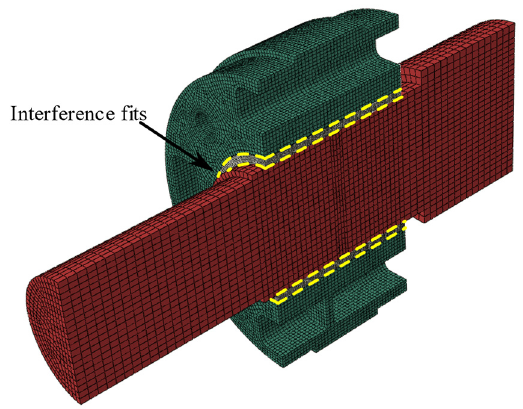
Figure 4. FE simulation procedure for the evaluation of the port effect of the interference fit.